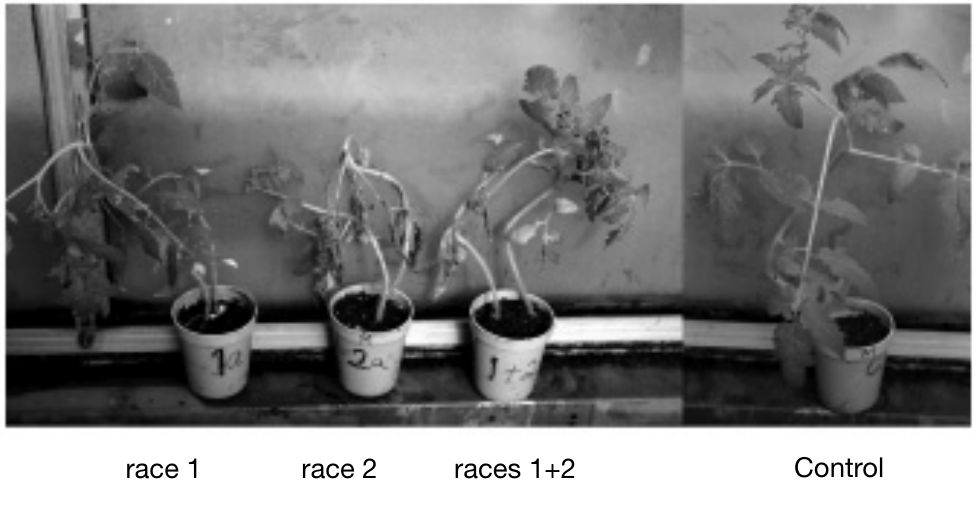
Fig. 1. Symptoms on the tomato cv. Momotaro inoculated with Fusarium oxysporum f. sp. lycopersici 24 days after inoculation. Plants were inoculated with race 1, and race 2, and jointly with races 1+2 by pouring the spore suspension (2.0×10 7 spores ml -1 ) on the soil around the plants. Control plants (control) were inoculated with water.